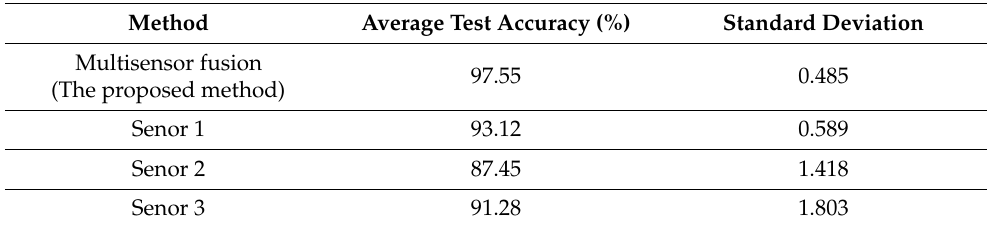
Figure 6. Comparison of 10 experiment results for different sensors’ datasets. Table 2. The diagnostic result of different sensor dataset.